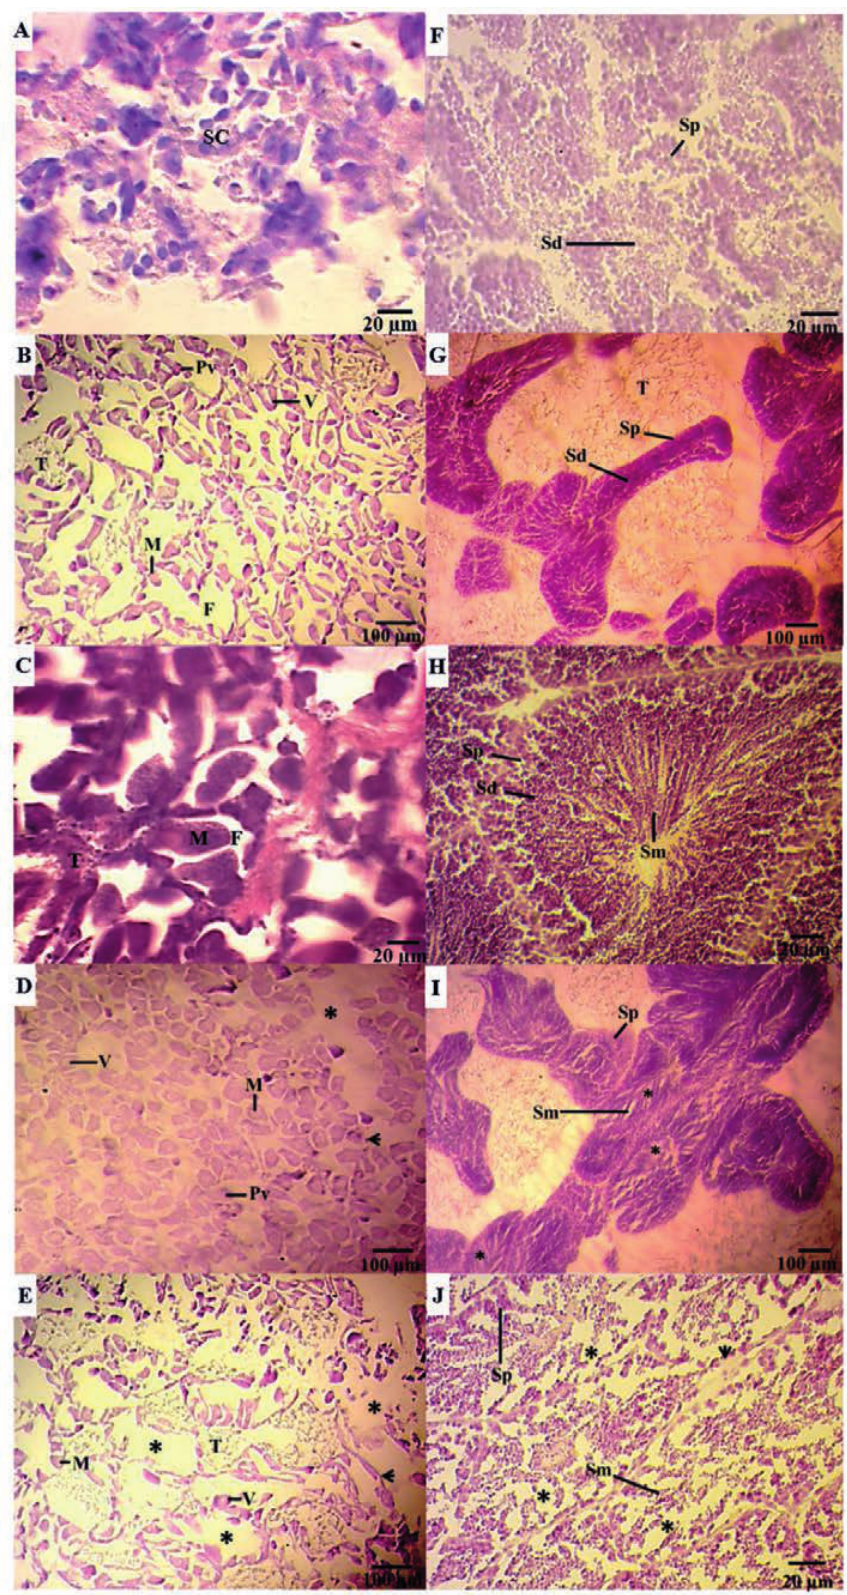
3. – Photomicrographs of the gonadal development stages in Donax striatus . A, immature female; B, female in maturation; C, ripe female; D, spawning female; E, female in cytolysis; F, immature male; G, male in maturation; H, ripe male; I, spawning male; J, male in cytolysis; SC, stem cell; PV, pre-vitellogenic oocytes; M, mature oocyte; V, vitellogenic oocyte; F, ovarian follicle; T, interfollicular tissue; Sm, spermatozoa; Sp, spermatocyte; Sd, spermatid; T, interfollicular tissue; * indicates empty spaces with the release of mature gametes and the arrows indicate the follicular